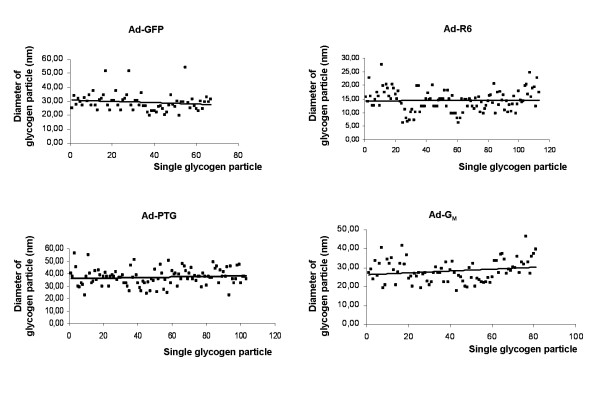
Diameter of glycogen particle. The graphics plot the diameter of each measured glycogen granule (at least 70 quoted granules for each condition) in cultured human myotubes transduced with Ad-GFP, Ad-R6, Ad-PTG or Ad-GM and incubated with 25 mM glucose for 48 h.